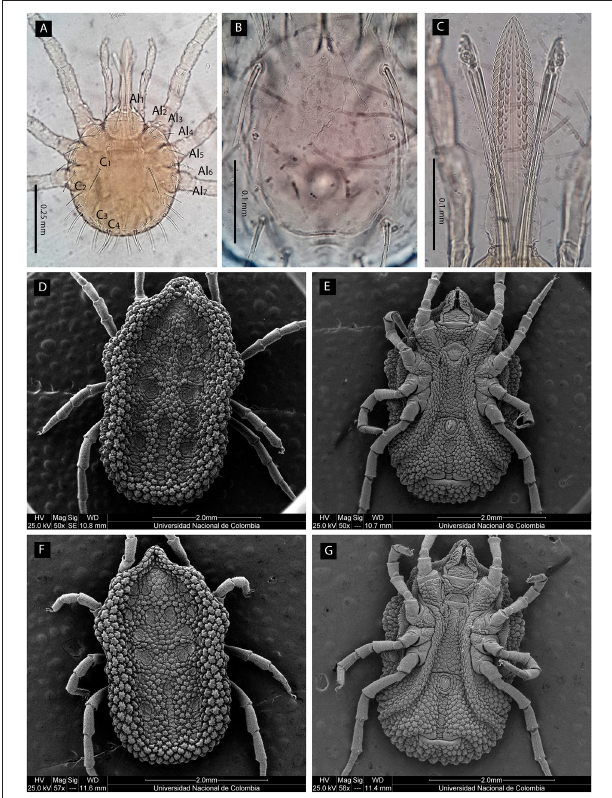
FIGURE 3 | Optical and scanning electron microscopic micrographs of O. puertoricensis collected in Córdoba department, Colombia. Larva: (A) dorsal view, (B) dorsal plate, and (C) hypostome. Female: (D) dorsal and (E) ventral views. Male: (F) dorsal and (G) ventral views. Al, anterolateral setae; C, central